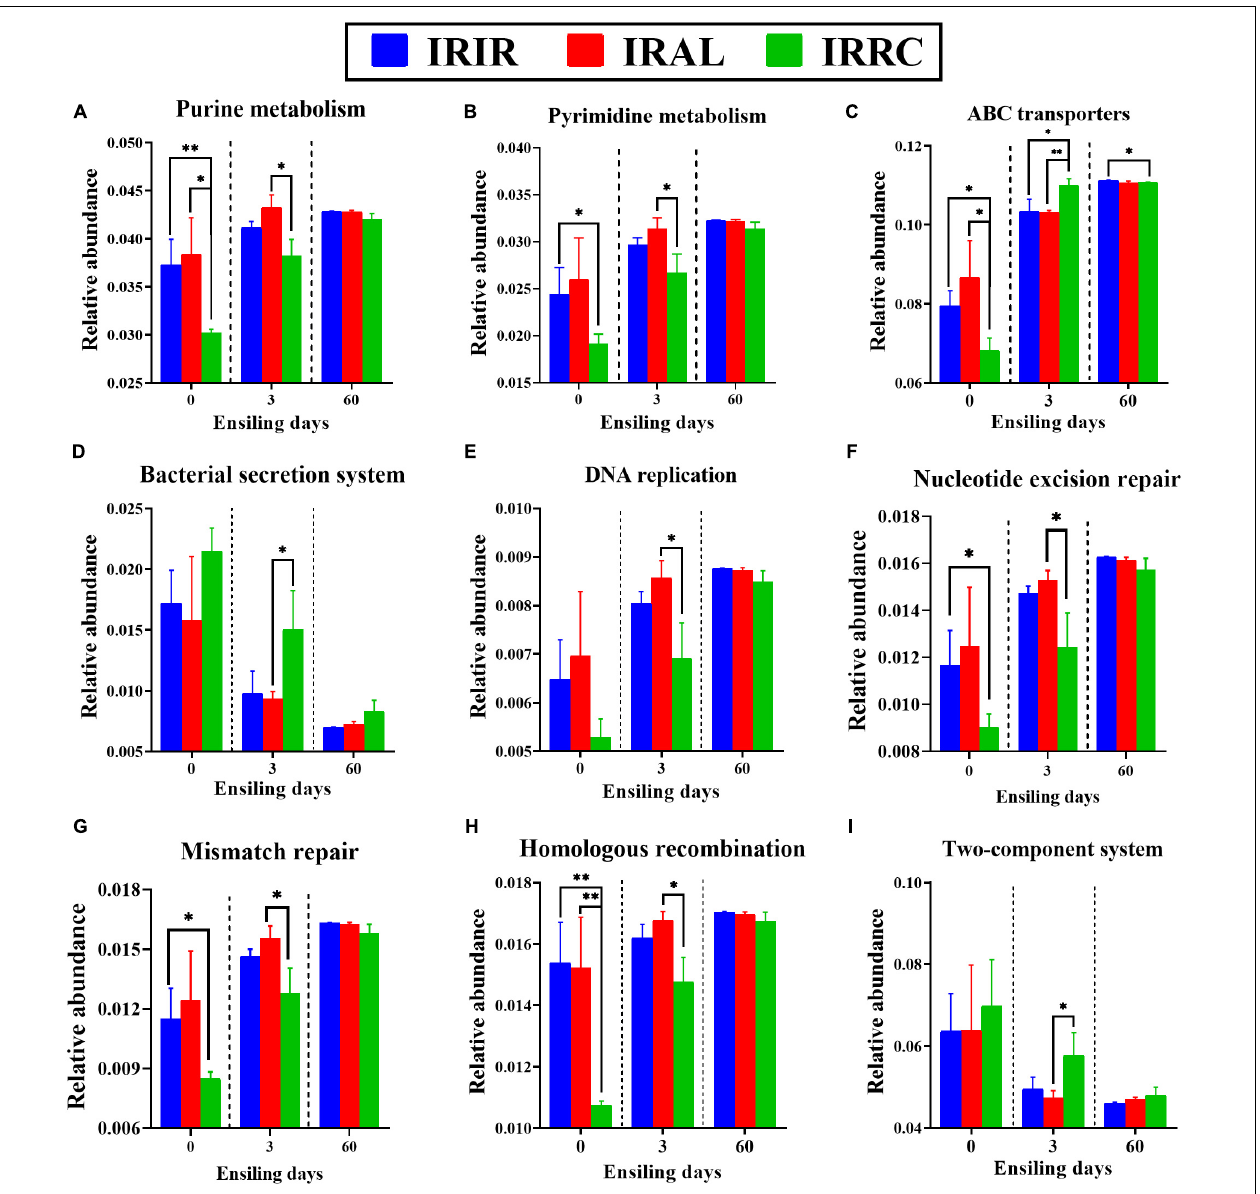
FIGURE 5 | The changes of some KEGG metabolic pathways on the nucleotide metabolism (A,B) , membrane transport (C,D) , replication and repair (E–H) , and signal transduction (I) obtained with Tax4Fun in different groups. KEGG, Kyoto Encyclopedia of Genes and Genomes; IRIR, sterile Italian ryegrass inoculated by epiphytic bacteria from Italian ryegrass; IRAL, sterile Italian ryegrass inoculated by epiphytic bacteria from alfalfa; IRRC, sterile Italian ryegrass inoculated by epiphytic bacteria from red clover. ∗ , 0.01 < p < 0.05; ∗∗ , 0.001 < p <